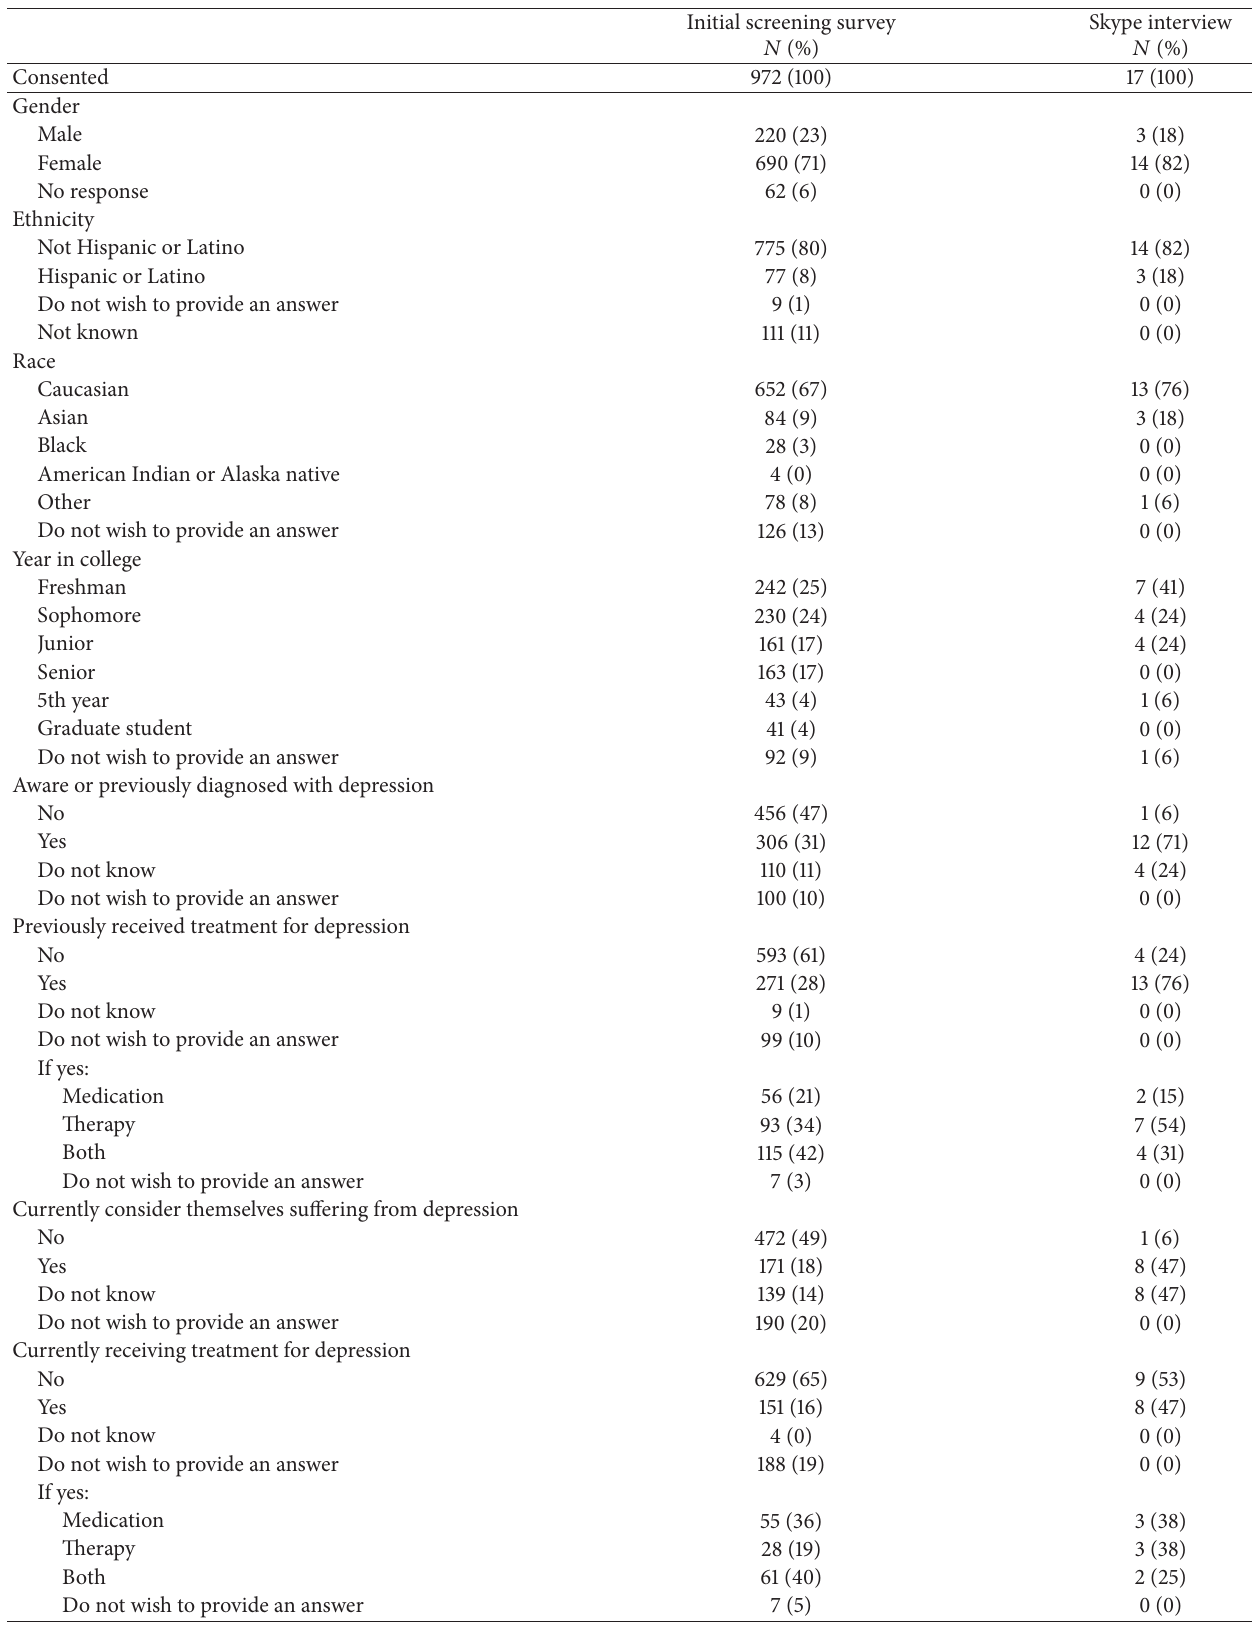
Table 1: Demographics of college students who participated in online depression screening survey and Skype interview.